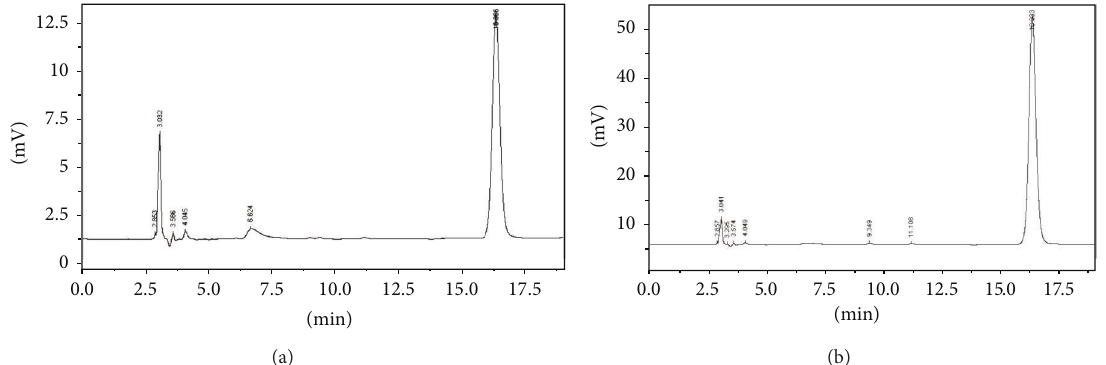
Figure 1: HPLC chromatogram of standard matrine (a) and sample (b).